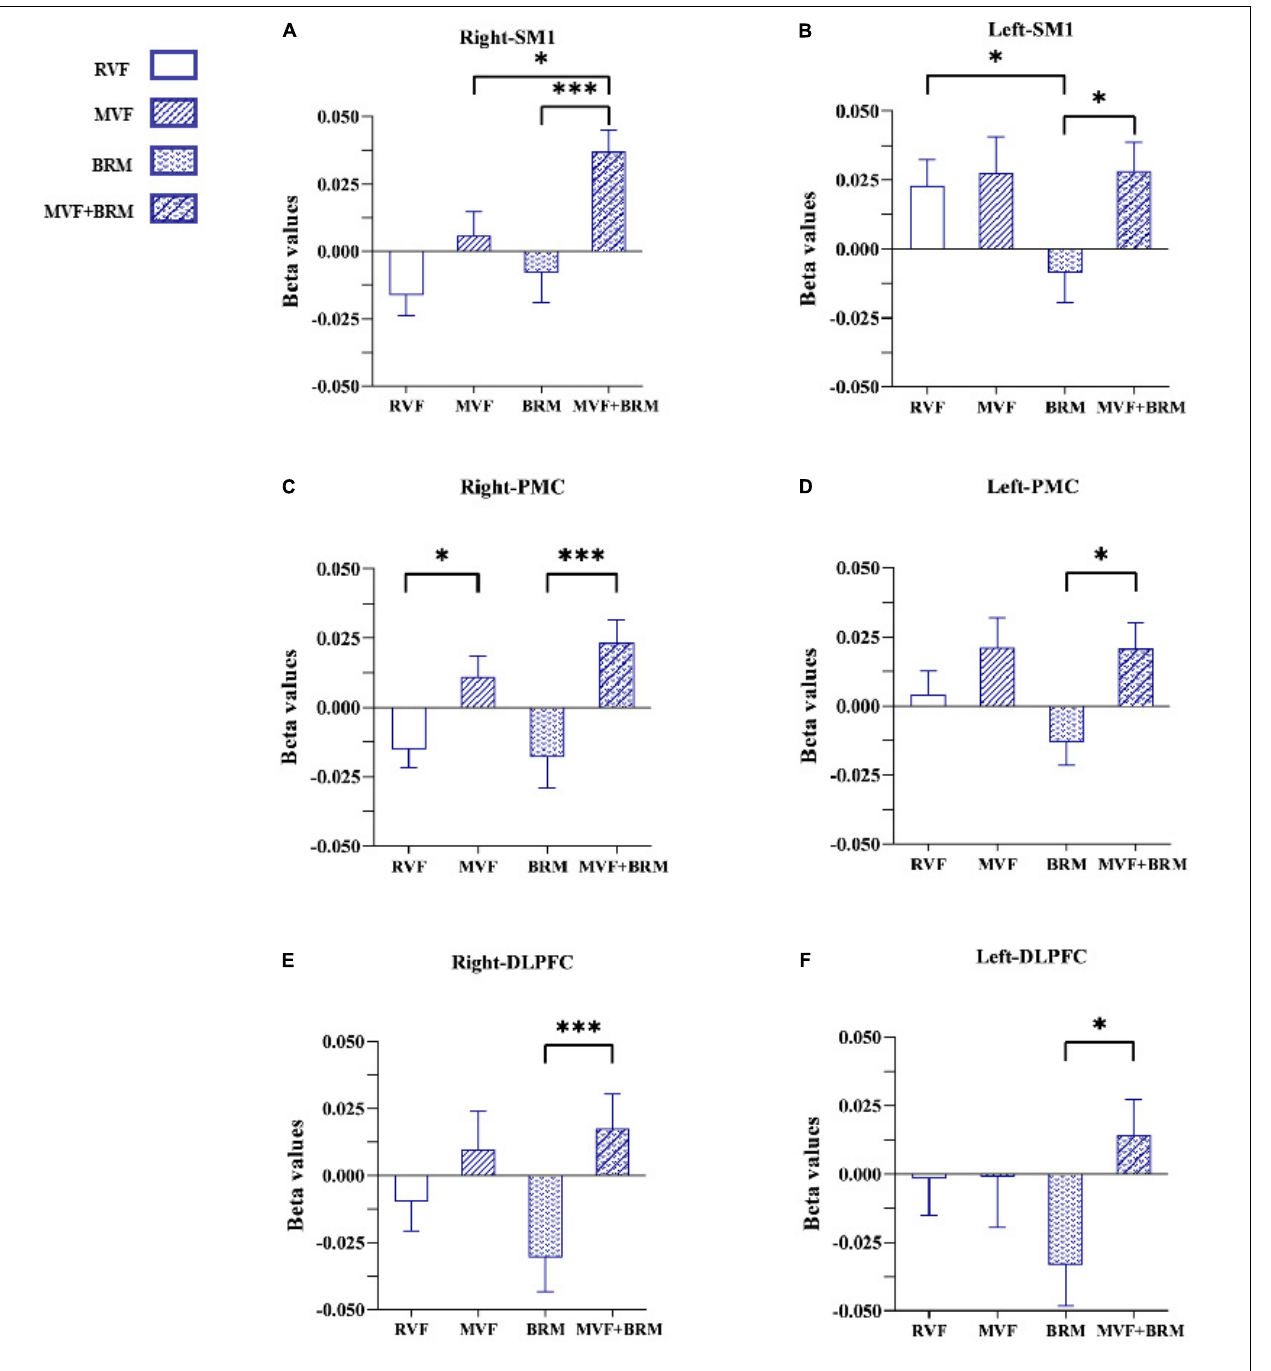
FIGURE 4 | The comparisons of average beta values of ROIs in different four visual feedback tasks. (A) Right-SM1; (B) Left-SM1; (C) Right-PMC; (D) Left-PMC; (E) Right-DLPFC; (F) Left-DLPFC. Error bars represent standard error. ∗ P < 0.05 and ∗∗∗ P < 0.001. RVF task, real visual feedback task; MVF task, mirror visual feedback task; BRM task, bilateral robotic movement task; MVF + BRM task, Mirror visual feedback combined with bilateral robotic movement task. SM1, primary sensorimotor cortex; PMC, pre-motor cortex; DLPFC, dorsolateral prefrontal